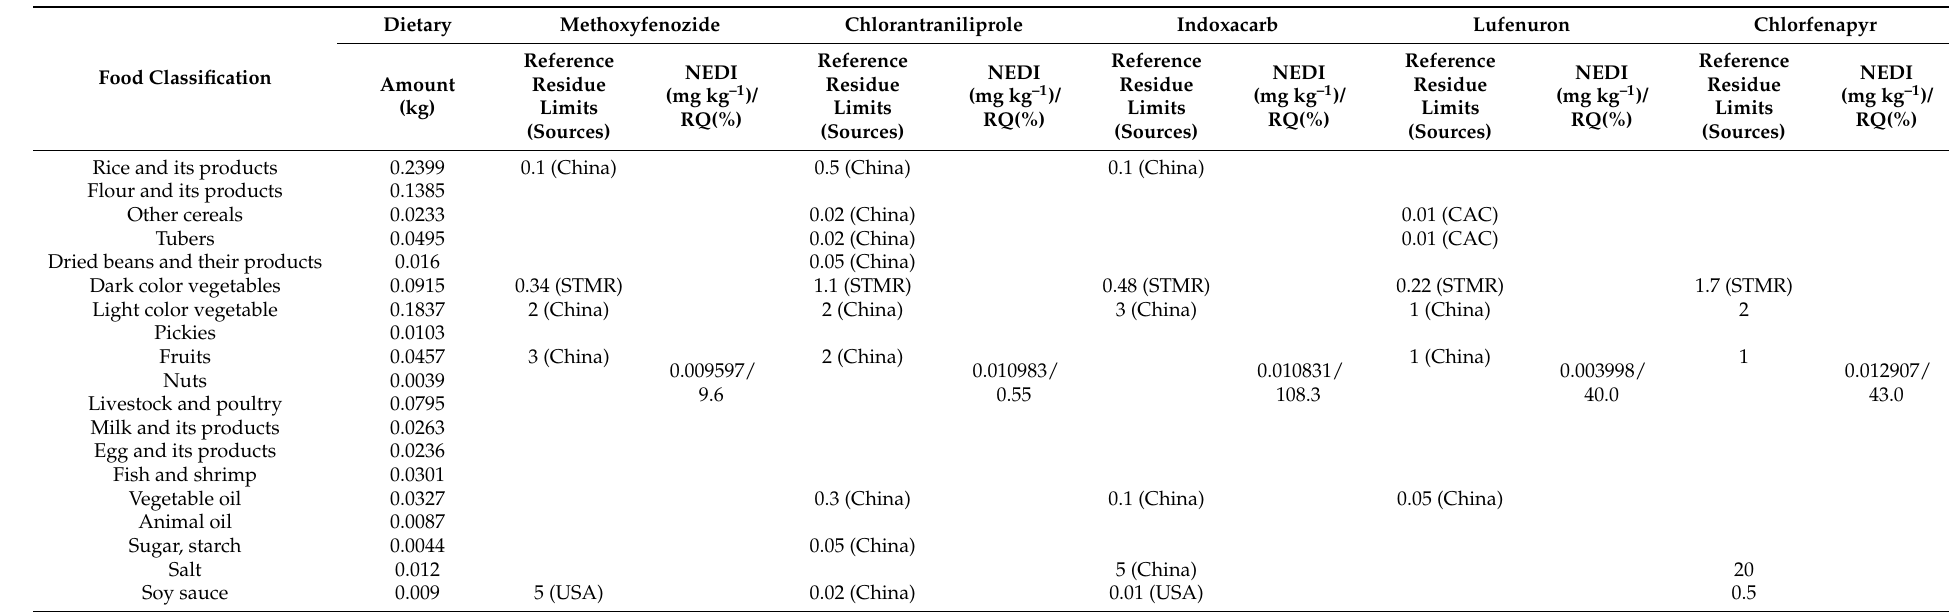
Table 5. Long-term dietary risk assessment of compounds in all of the registered crops in